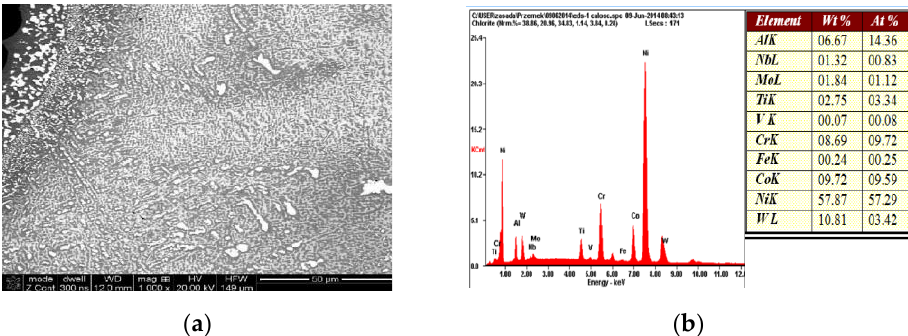
Figure 11. Result of the microanalysis of the chemical composition of the material of the HPT blade. The area subject to microanalysis ( a ), the spectrum of identified elements ( b ). The maximum exploitation temperature of the MAR-M 200 alloy is (according to